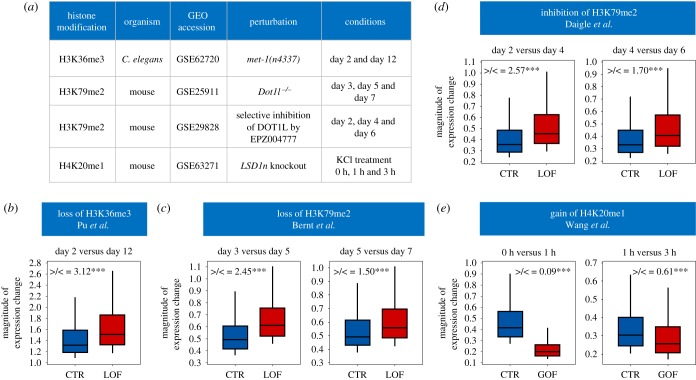
Perturbing histone modifications affects magnitude of gene expression changes. (a) Gene expression datasets used to validate the effect of histone modifications on GEP. (b–e) Perturbation of H3K36me3 (b), H3K79me2 (c,d) and H4K20me1 (e) induced expected changes in the magnitudes of gene expression changes between two conditions. Absolute log2-fold changes of gene expression between two conditions were used to proximate GEP changes. Box plots show magnitudes for the most dynamically expressed genes (top 20%) in control (CTR) and loss (LOF) or gain (GOF) of function mutations. Gene numbers for all datasets are: n = 535 from Pu et al. [37]; n = 141 (day 3 versus day 5) and n = 190 (day 5 versus day 7) from Bernt et al. [40]; n = 1483 (day 2 versus day 4) and n = 460 (day 4 versus day 6) from Daigle et al. [41]; and n = 1062 (0 h versus 1 h) and n = 1106 (1 h versus 3 h) from Wang et al. [42] >/< indicates the ratio of the number of genes exhibiting larger magnitudes of change to those exhibiting smaller magnitudes for genes having the same direction of expression change between two conditions. *** denotes a ratio significantly different from expected (Fisher's exact test, p < 0.001).